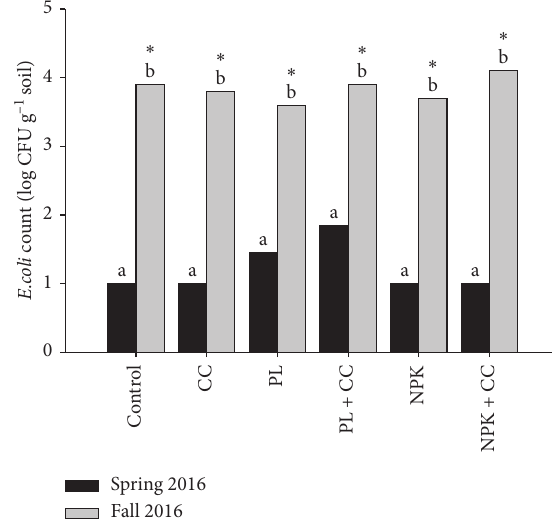
Figure 2: Treatment effects of poultry litter compost (PL) and chemical fertilizers (NPK) with or without cover crops (CC) and an unamended control on the numbers of E. coli (logCFU · g − 1 soil) in Spring and Fall of 2016. Different letters above each bar indicate significant differences between treatments within a sample period at p < 0 . 05. Within a treatment, asterisks indicate significant dif- ference between sampling periods (Spring and Fall in a given year) at ( p < 0 . 05). Only sample season was a significant effect.